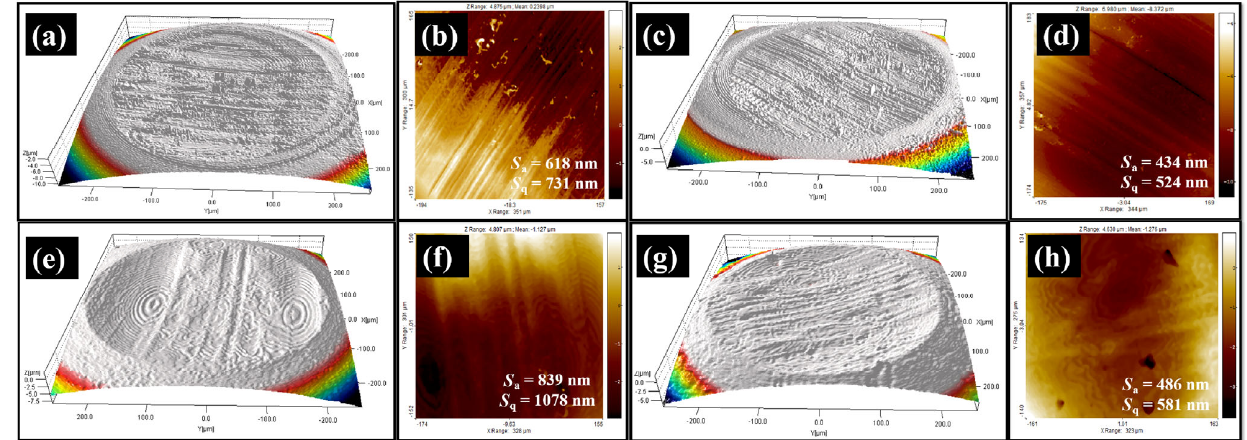
Fig. 10 Optical profilometry images of worn surfaces along with surface roughness values: (a, b) at 29  C and (e, f) at 75  C for base oil, (c, d) at 29  C and (g, h) at 75  C for 0.00625 mg/ml